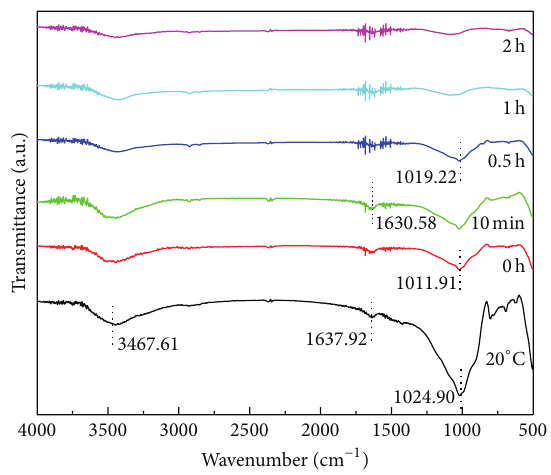
Figure 3: IR spectra of samples isothermally heated at 820 ∘ C.